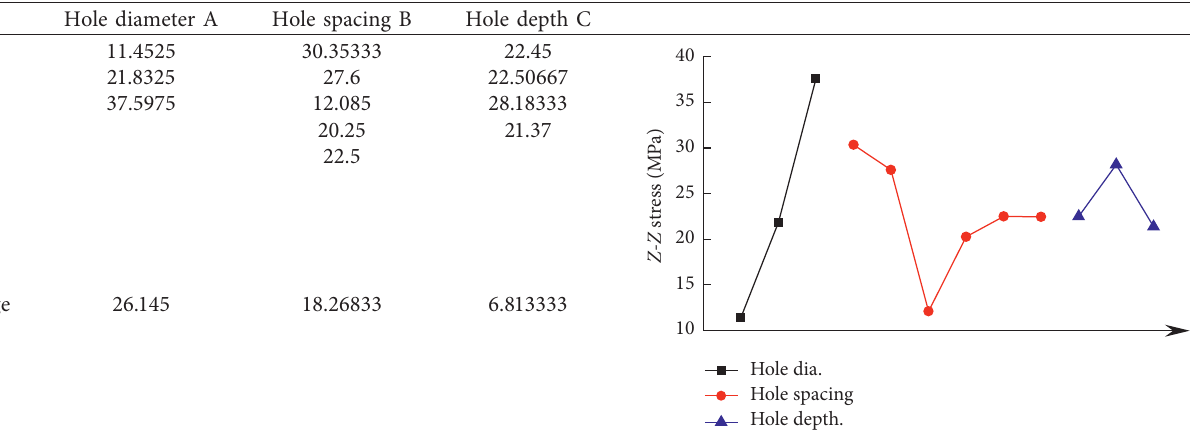
Table 8: Stress Δ U range of each